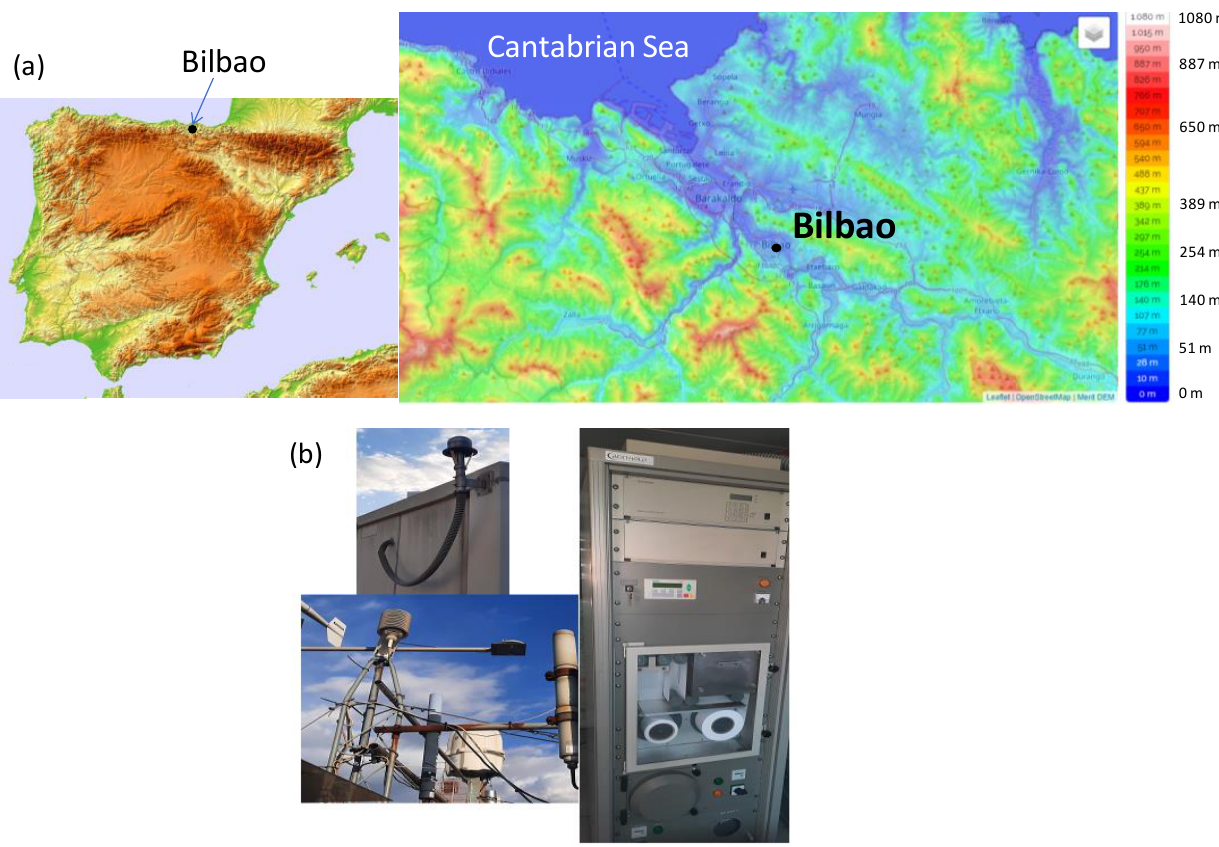
Figure 1. ( a ) Location of the study site in the Iberian Peninsula and the topographic map of the nearby area, and ( b ) the meteorological station and the radon measurement system at Bilbao. This area could be classified as low natural radioactivity background based on the value of U contents in soil, gamma dose rate, and radon fluxes. According to the Euro- pean Map of Uranium in soil (https://remon.jrc.ec.europa.eu/About/Atlas-of-Natural- Radiation/Digital-Atlas/Uranium-in-soil/Uranium-concentration-in-soil-, accessed on 10 October 2022), Bilbao area shows values of uranium between 1.6 and 2.4 mg/kg. The map of natural gamma radiation in Spain—MARNA shows values below 10 µ